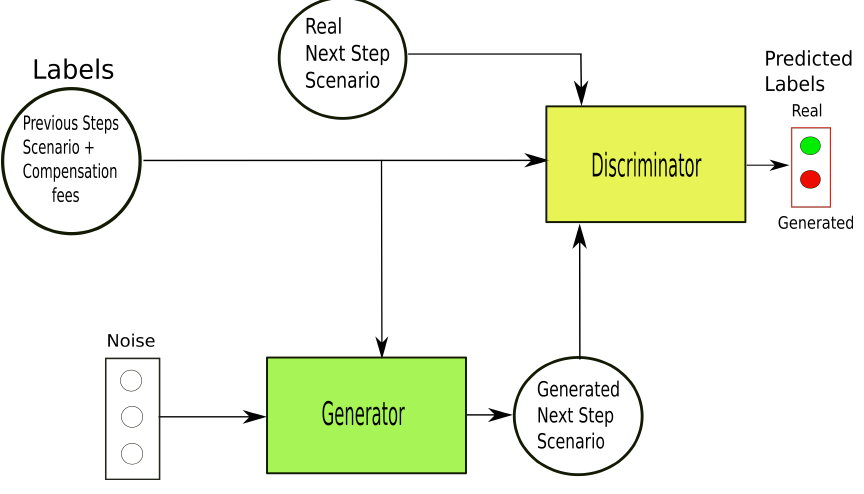
Figure 2. Conditional